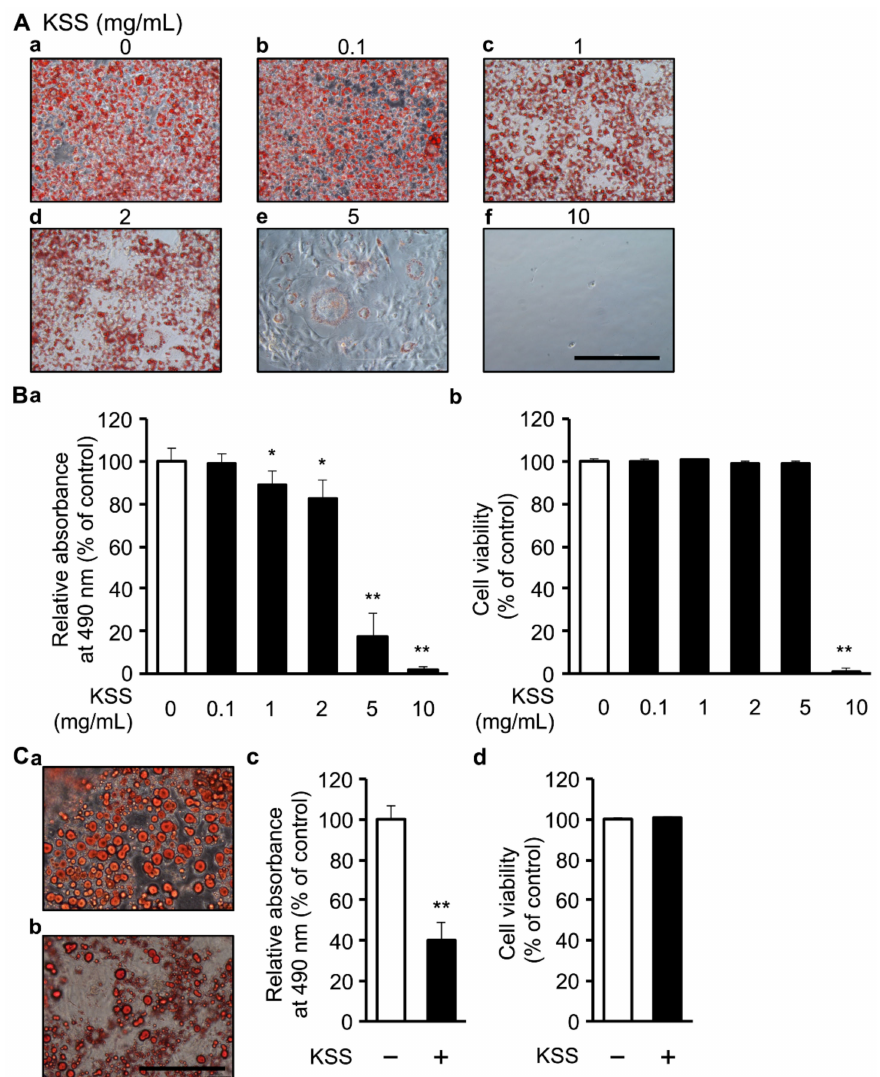
Figure 2. KSS reduces lipid accumulation in a dose-dependent manner. ( A ) KSS inhibited lipid accumulation in 3T3-L1 cells induced by the DMI method in a dose-dependent manner. Oil-Red-O staining images of cells cultured for 8 days is shown. ( Aa ) KSS 0 mg / mL, ( Ab ) 0.1 mg / mL, ( Ac ) 1 mg / mL, ( Ad ) 2 mg / mL, ( Ae ) 5 mg / mL, and ( Af ) 10 mg / mL. The scale bar indicates 200 µ m. ( B ) KSS inhibited the lipid accumulation in 3T3-L1 cells cultured for 8 days in a dose-dependent manner. As in Figure 1, ( Ba ) the amount in lipid accumulation and ( Bb ) the cell viability was measured. ( C ) KSS suppressed lipid accumulation after 21 days of administration. ( Ca , b ) Oil-Red-O staining images of cultured cells are shown. ( Ca ) KSS (0 mg / mL) and ( Cb ) KSS (2 mg / mL). The scale bar indicates 200 µ m. As in ( B ), ( Cc ) the amount of lipid accumulation was measured and is expressed as relative absorbance. ( Cd ) Cell viability. Data are shown as the mean ± standard deviation ( n = 3). * p < 0.05 and ** p < 0.01 vs. H 2